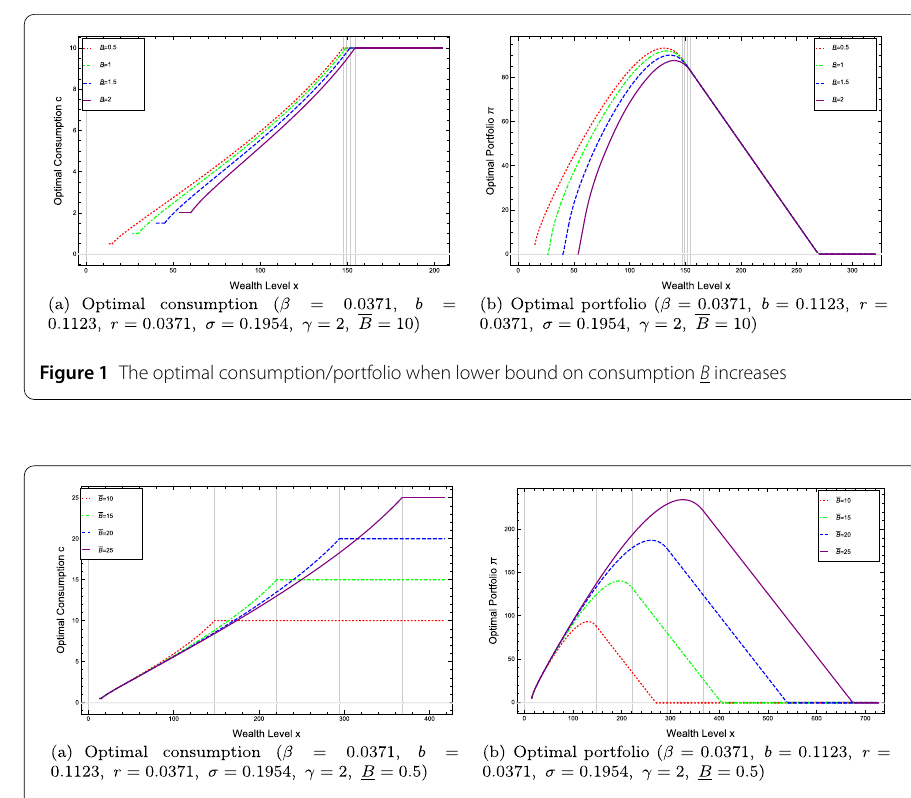
Figure 2 The optimal consumption/portfolio when upper bound on consumption B